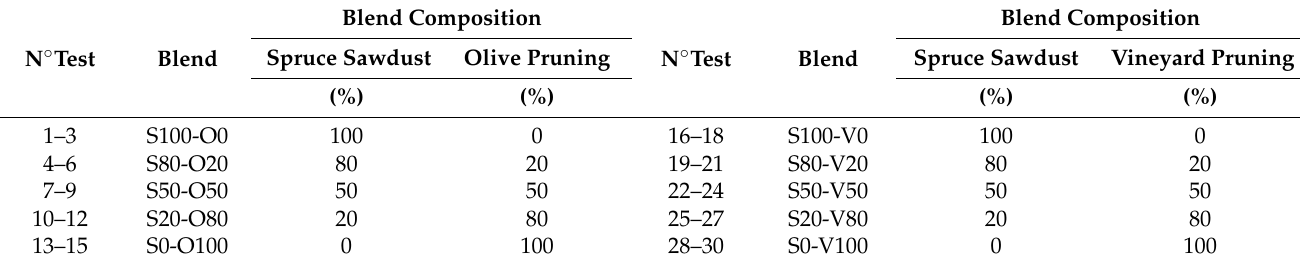
Table 1. Work plan of pelletisation tests.